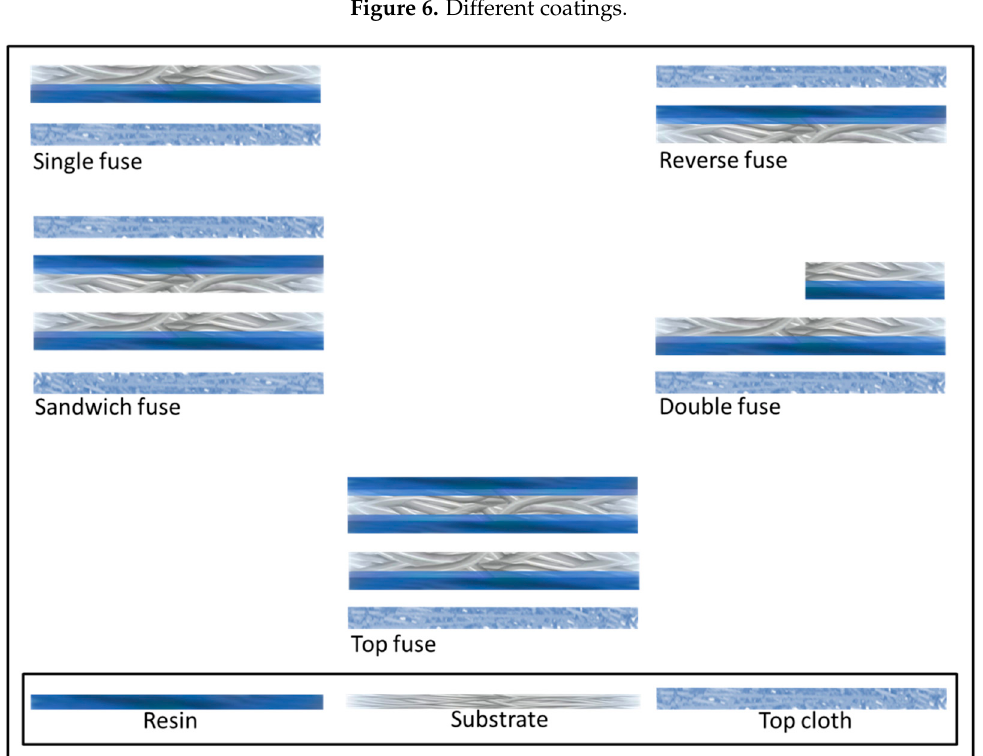
Figure 7. Fusing methods. Figure 7. Fusing